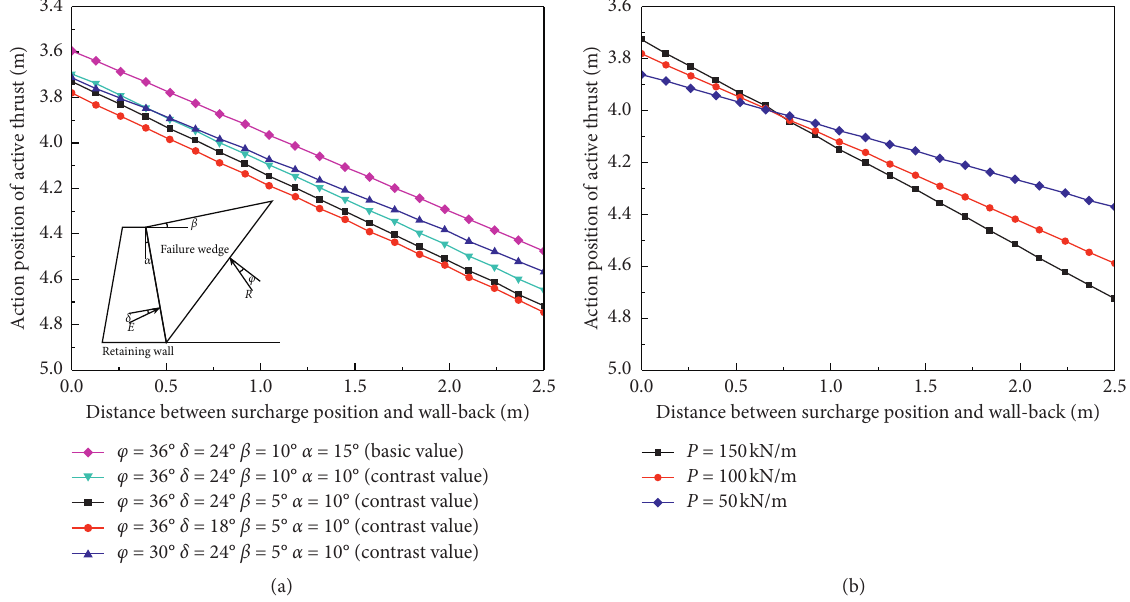
Figure 9: Variation of the active position Z to the concentrated